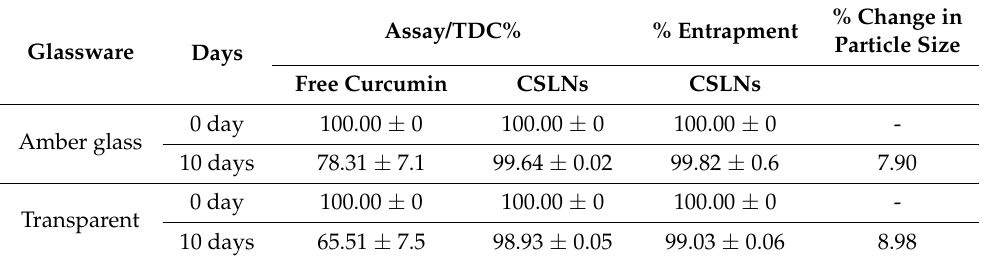
Table 7. Photostability studies on optimized CSLN formulation ( n = 3).